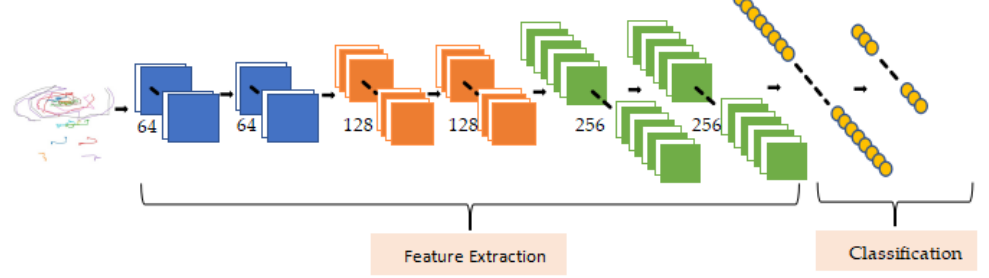
Figure 6. CNN-based action recognition model structure.